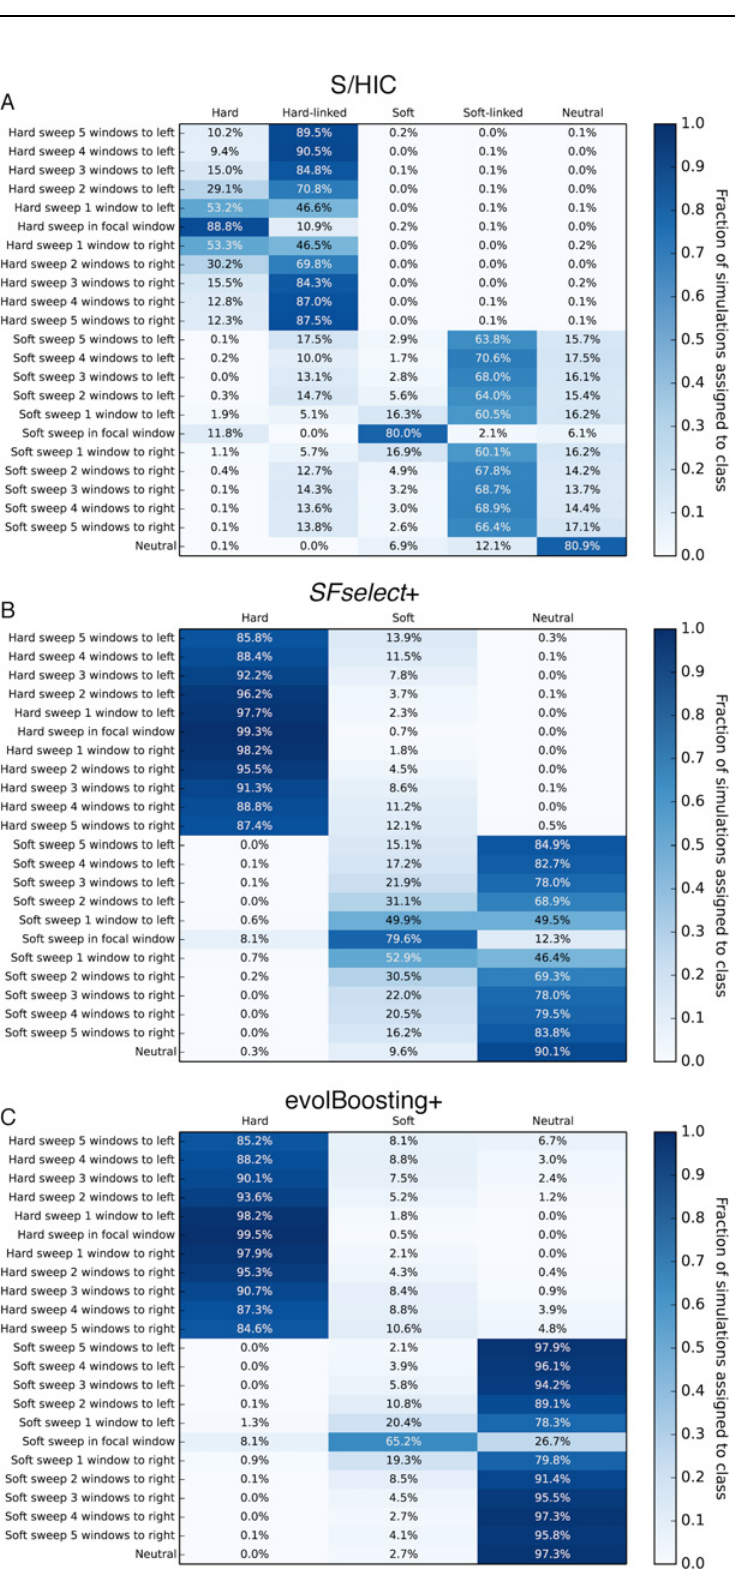
Fig 5. Heatmaps showing the fraction of regions at varying distances from strong sweeps inferred to belong to each class by S/HIC, SFselect+ , and evolBoosting+. The location of any sweep relative to the classified window (or "Neutral" if there is no sweep) is shown on the y -axis, while the inferred class on the x - axis. Here, α ~ U (2.5×10 3 , 2.5×10 4 ). A) Results for S/HIC. B) SFselect +. C)